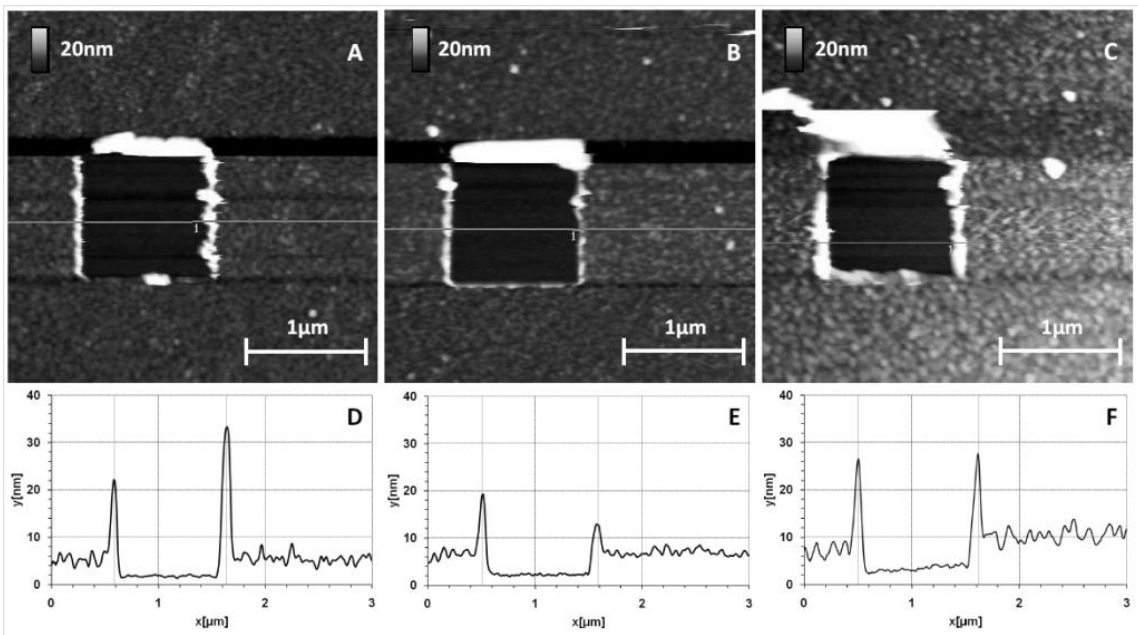
Figure 6. AFM images after strong scraping applied to GaAs biofunctionalized surfaces. Images and corresponding sections: 0% MHDA ( A , D ); 100% MHDA ( B , E ); and 10% MHDA ( C , F